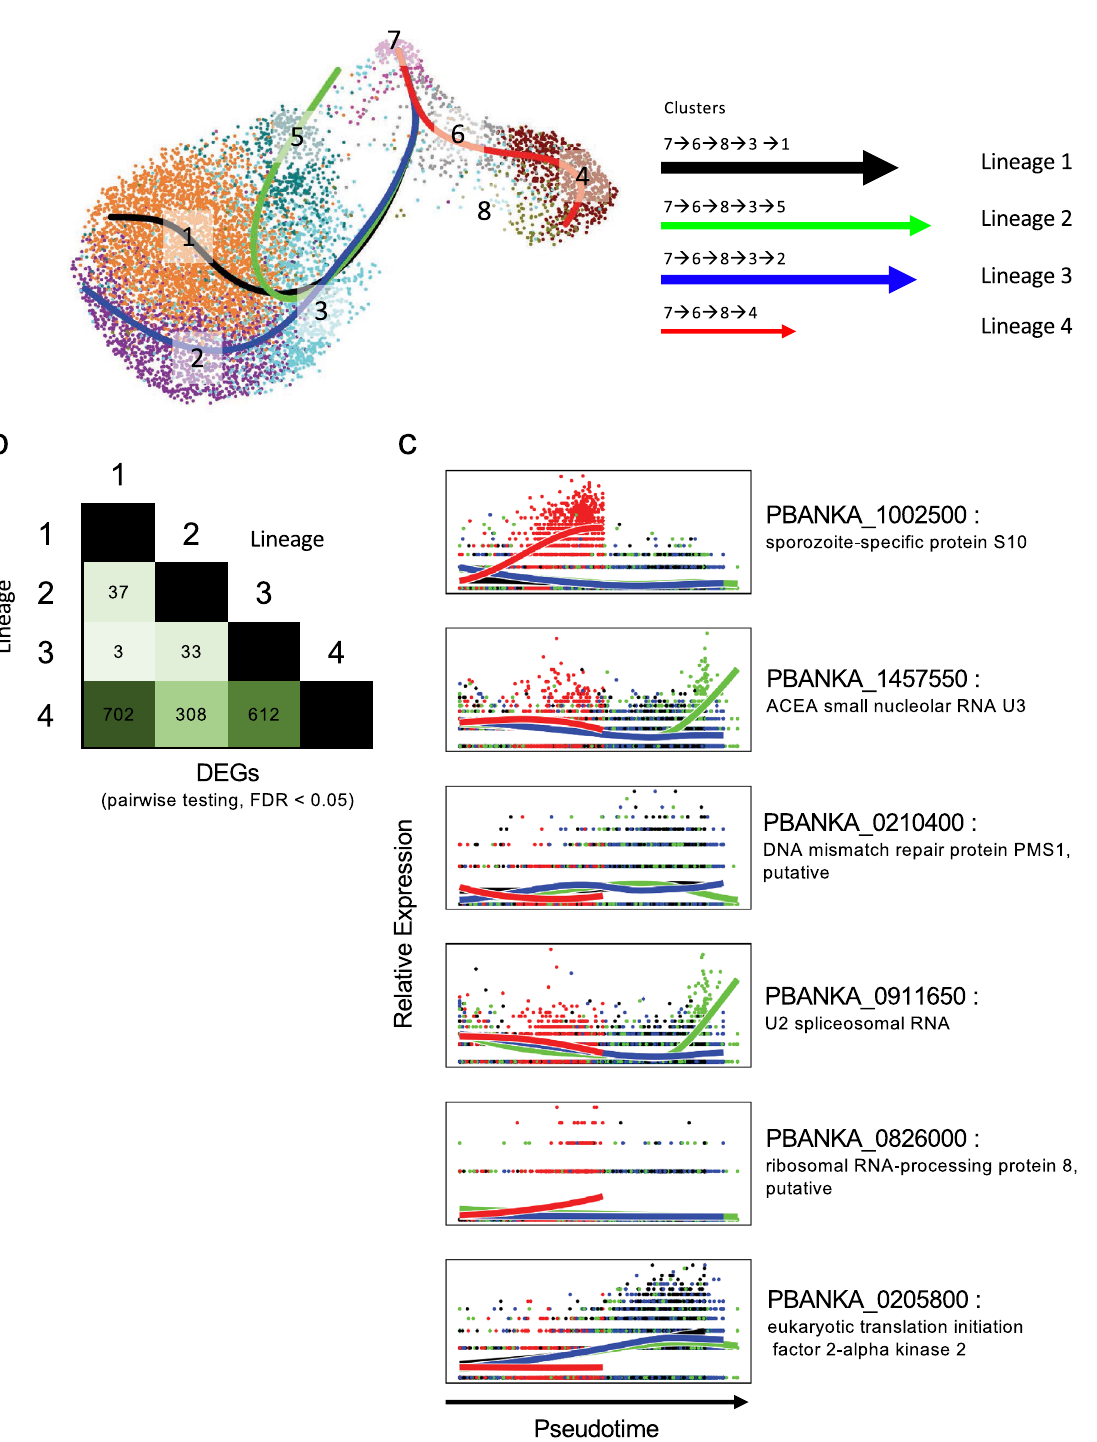
Figure 4. Pseudotime analysis of SG and MID sporozoite markers. ( a ) UMAP representation of SG and MID sporozoites clusters overlaid with the four principal curves identified using Slingshot to reveal potential developmental trajectories (lineages). Arrow width represents the relative number of cells in each lineage; length of arrows represents the length of trajectories for each lineage. ( b ) Number of DEGs when performing pairwise tests between each of the lineages. ( c ) Smoothed expression across the differentiation trajectories in SG and MID sporozoites for top genes changing across pseudotime. See Supplementary Table S6 for the complete